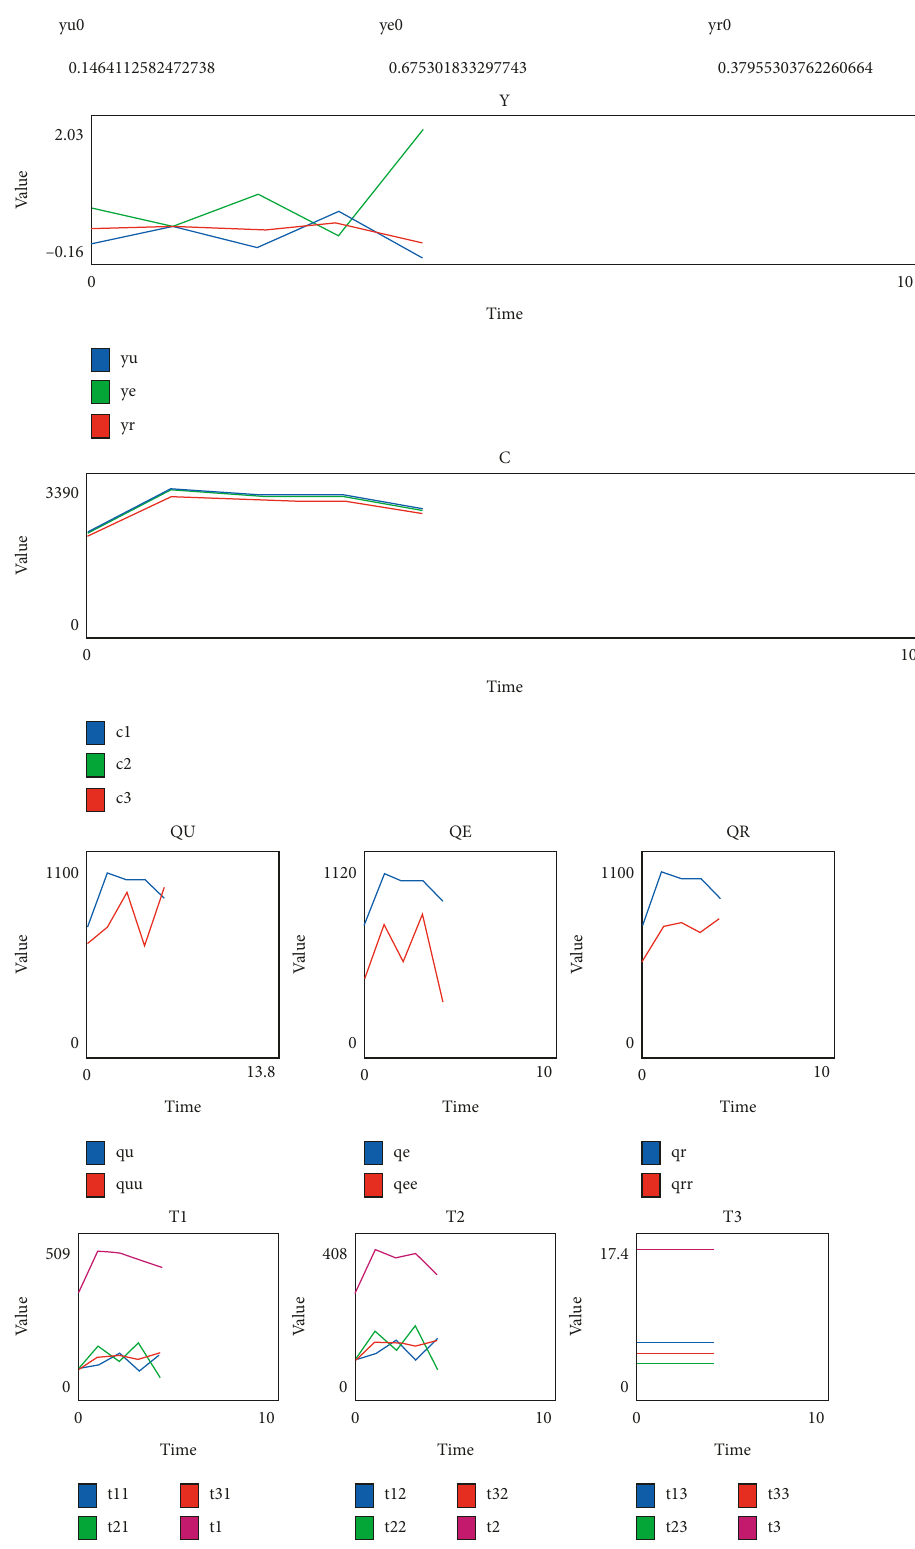
Figure 7: Simulation results of scenario